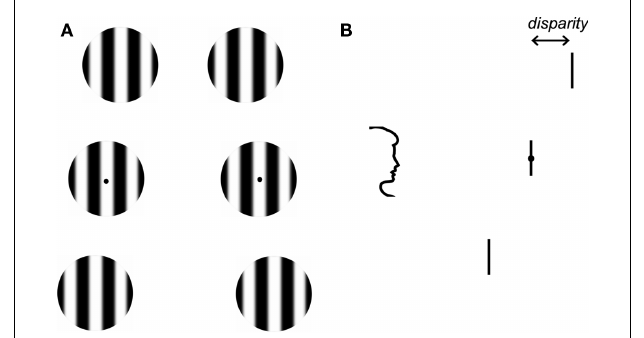
FIGURE 1 | Front and side views of the stimulus. (A) Stimuli were three vertically arranged grating patches. Each patch was 0.8˚ in diameter and they were separated by 1˚.The gratings presented to each eye could vary in either: spatial frequency, orientation, spatial phase, or direction of motion. (B) The top and bottom of the three grating patches in each monocular image were given equal and opposite horizontal disparities such that one or other was in front of fixation during the stereo presentation.The task of the participant was to press a button to indicate which grating patch was closest and then to report the appearance of the